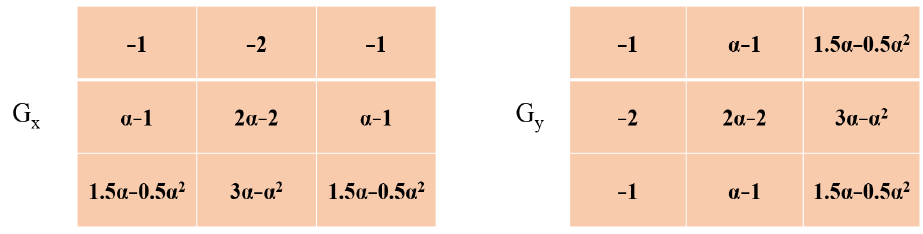
Figure 6. Left-side-oriented fractional-order masks using Sobel.